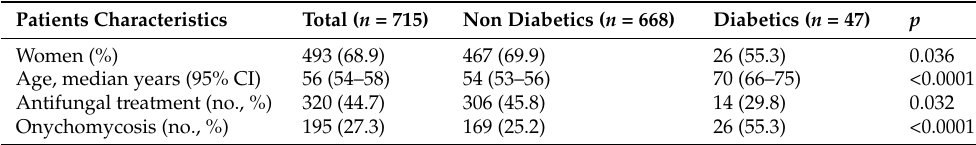
Table 2. General characteristics of patients enrolled in the study.